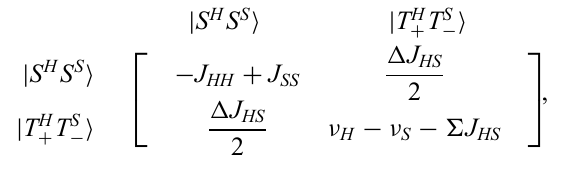
≈ 1.5 Hz, J ≈ 0 Hz, and HS HS